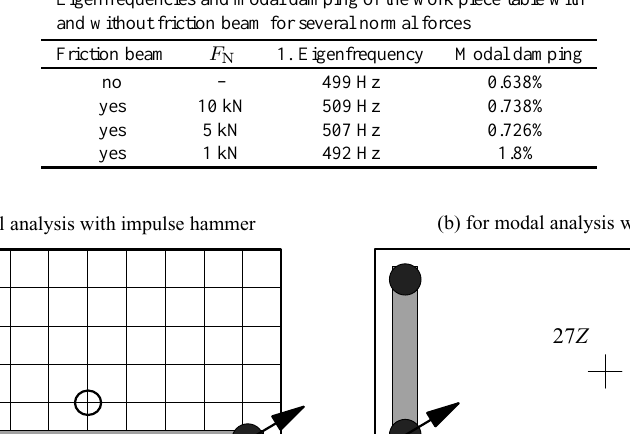
Table 1 Eigenfrequencies and modal damping of the work piece table with